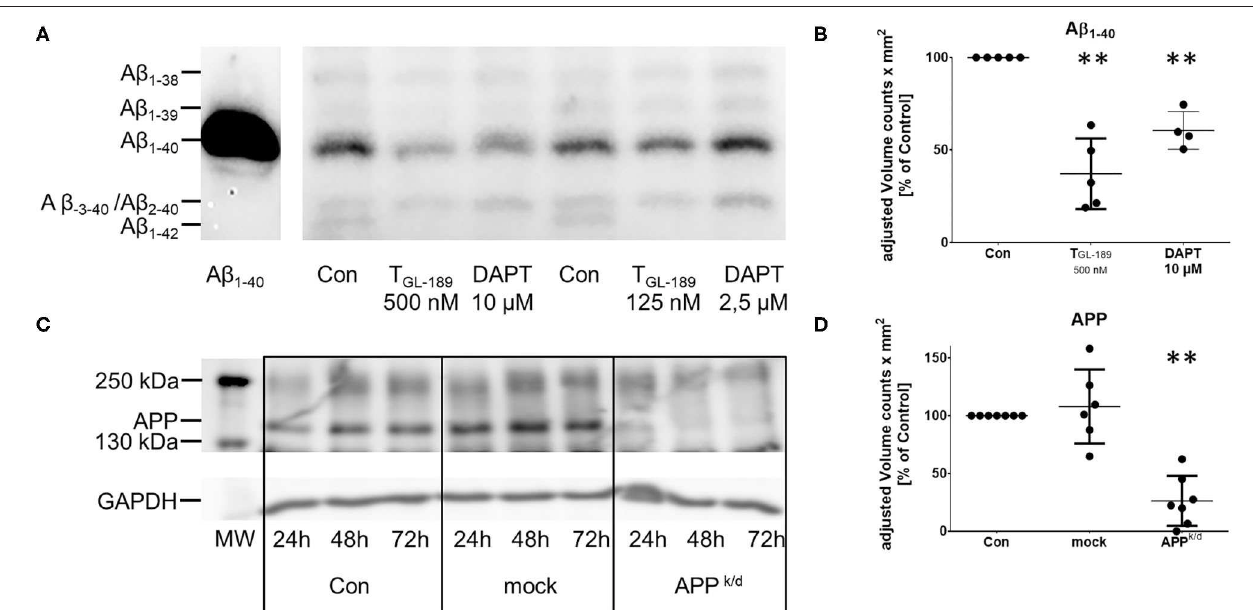
FIGURE 1 | Reduced secretion of A β peptides after treatment with T GL − 189 and DAPT. Reduced expression of APP after knock/down of APP with siRNA. (A,B) representative western blot and semiquantitative assessment of the A β peptides secreted by primary human macrophages after inhibition of APP processing by the β -secretase inhibitor T GL − 189 or the γ -secretase inhibitor DAPT. 72h after the addition of T GL − 189 or DAPT in the indicated concentrations the media were collected. Cultures treated only with the solvent of the substances (dimethyl sulfoxide, DMSO) served as control (Con). A β peptides were analyzed after immunoprecipitation by SDS-Page containing 8M Urea and subsequent immunoblot. A β 1-40 was added as a standard. The bands are labeled according to previously published in depth analysis of A β peptides secreted by monocytes/macrophages ( 22–24). According to the results, a concentration of 500nM for T GL − 189 and 10 µ M for DAPT were chosen for the experiments. (C,D) Representative western blot and semiquantitative assessment of mature, fully glycosylated macrophage APP 24, 48, and 72h after siRNA knock-down of APP. The quantification (D) was performed 72h after the transfection. Transfection of non-coding siRNA served as additional control (mock). The analysis of A β and APP was performed at the same time point, when the experiments were carried out. Each point represents the result of a biological replicate. MW, molecular weight marker, ** p < 0.01; *** p < 0.001 as compared to control